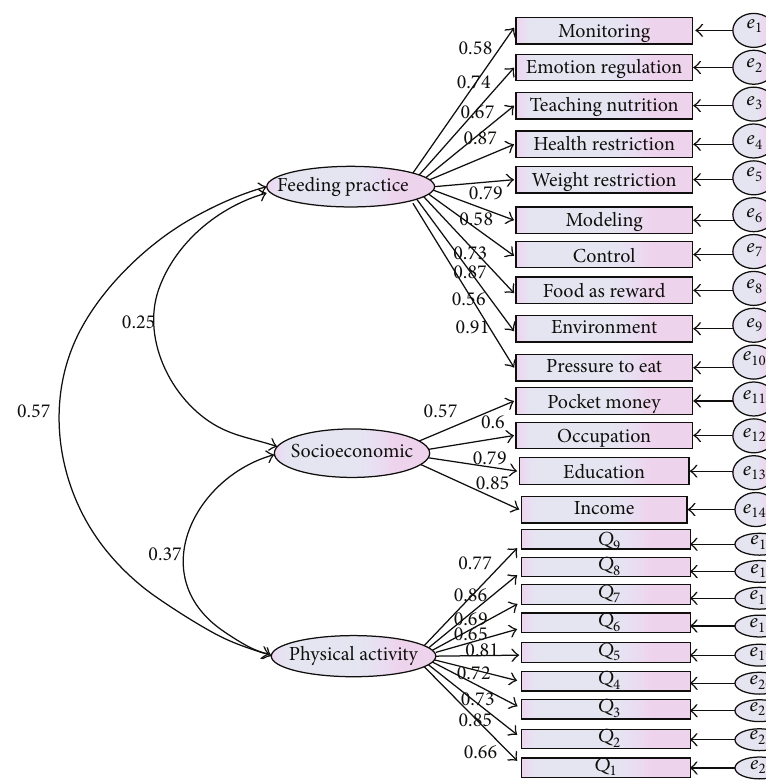
Figure 6: Measurement model in same line (without exogenous or endogenous variables).